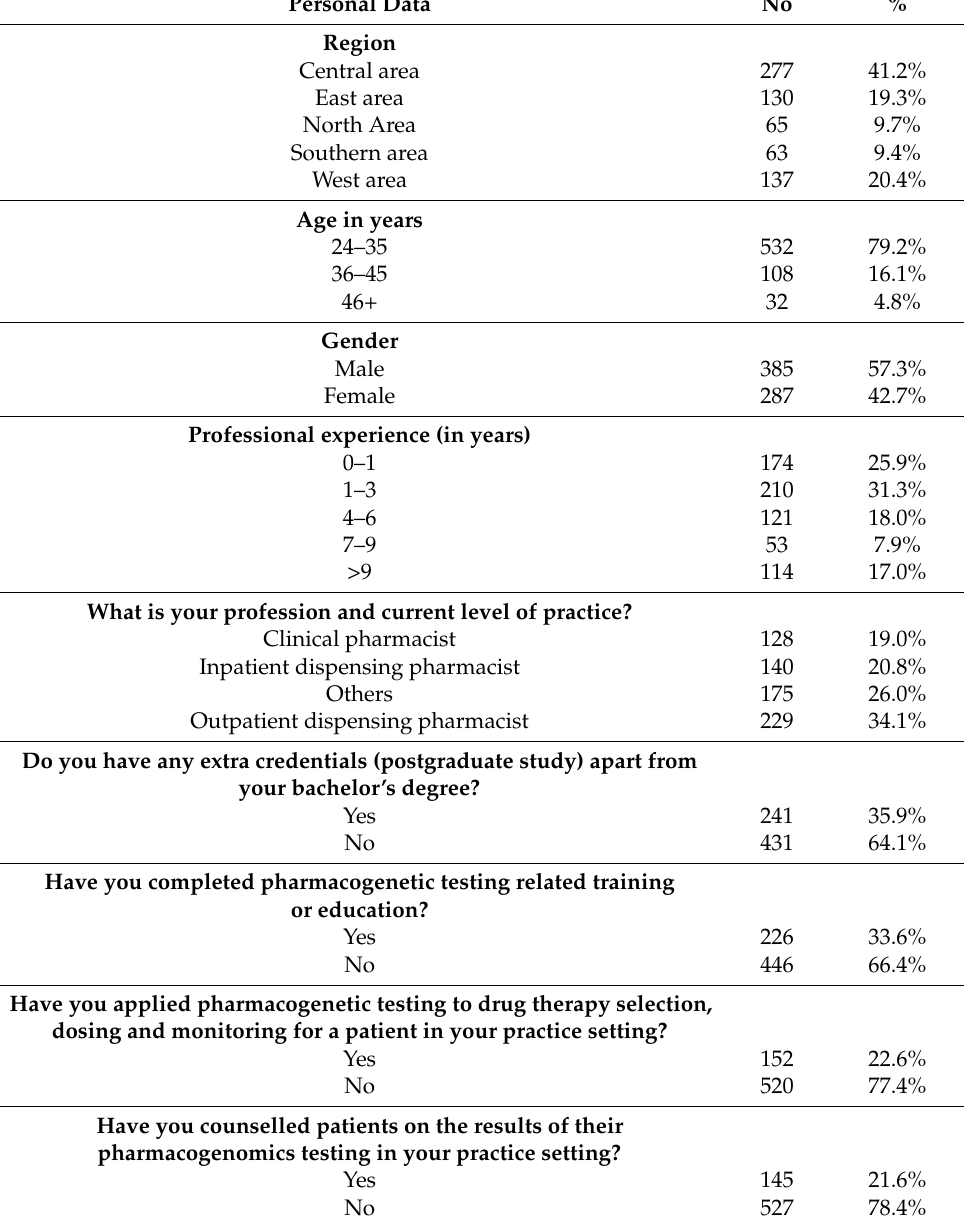
Table 1. Demographic characteristics and professional information of the participants ( n =